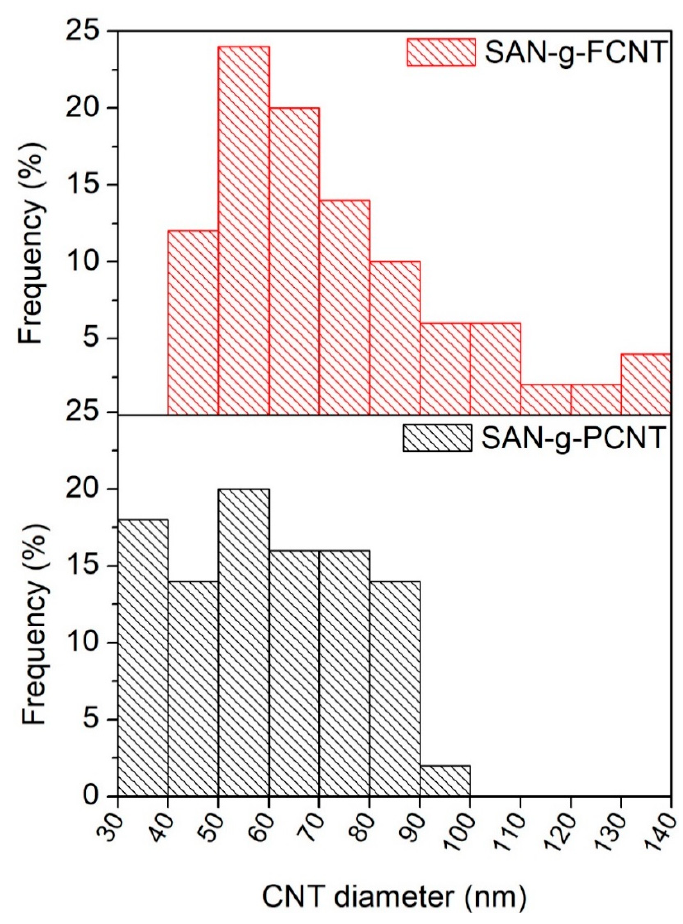
Figure 10. Diameter distribution histograms of SAN-grafted CNTs.